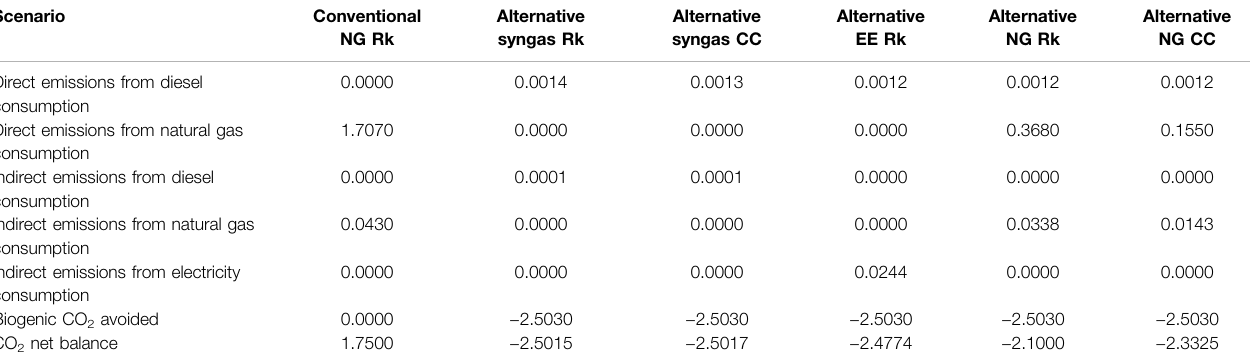
TABLE 4 | Direct and indirect emissions for diesel, natural gas (NG) and Electricity (EE). The net CO 2 emissions balance of the scenarios studied is also reported (t CO2 /t NH3